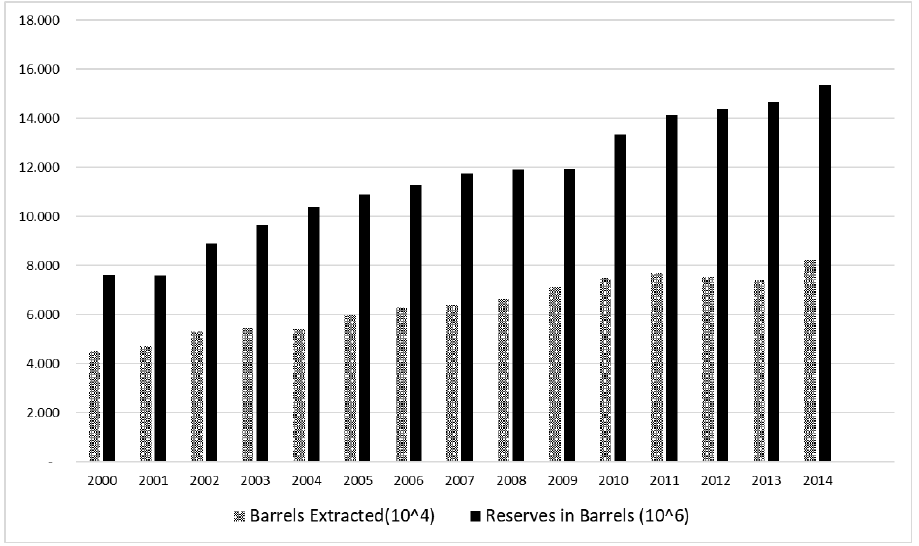
Fig. 2. Barrels extracted and reserves (in barrels) per year in